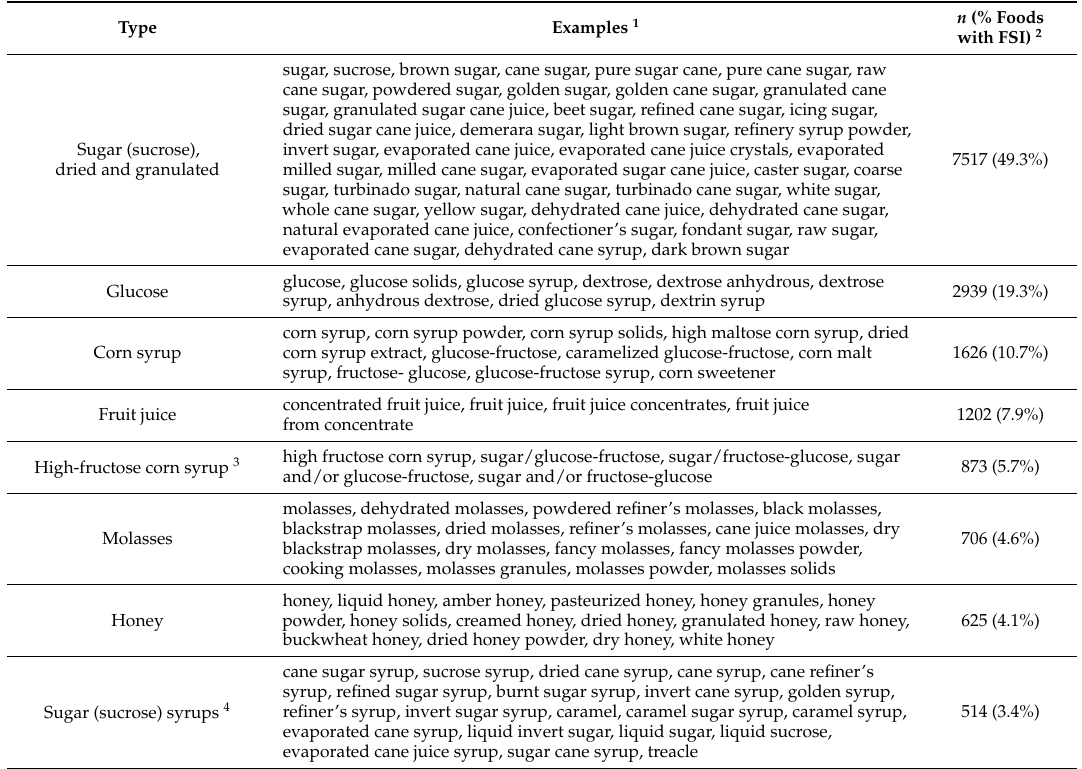
fructose ‐ glucose, glucose ‐ fructose syrup, corn sweetener